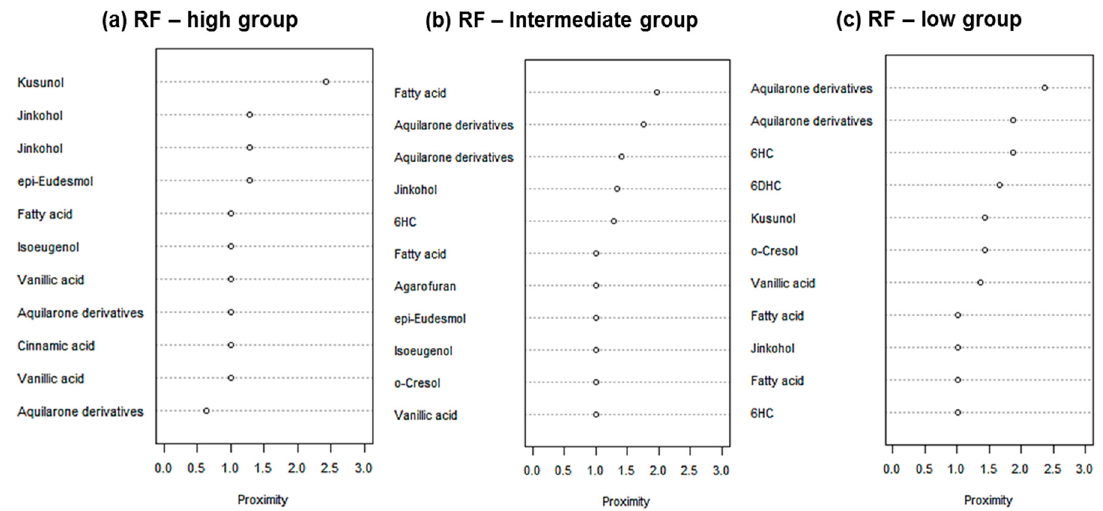
Figure 4. Variable importance (VIP) values for ( a ) high; ( b ) intermediate and ( c ) low grade clusters based on Random Forests.